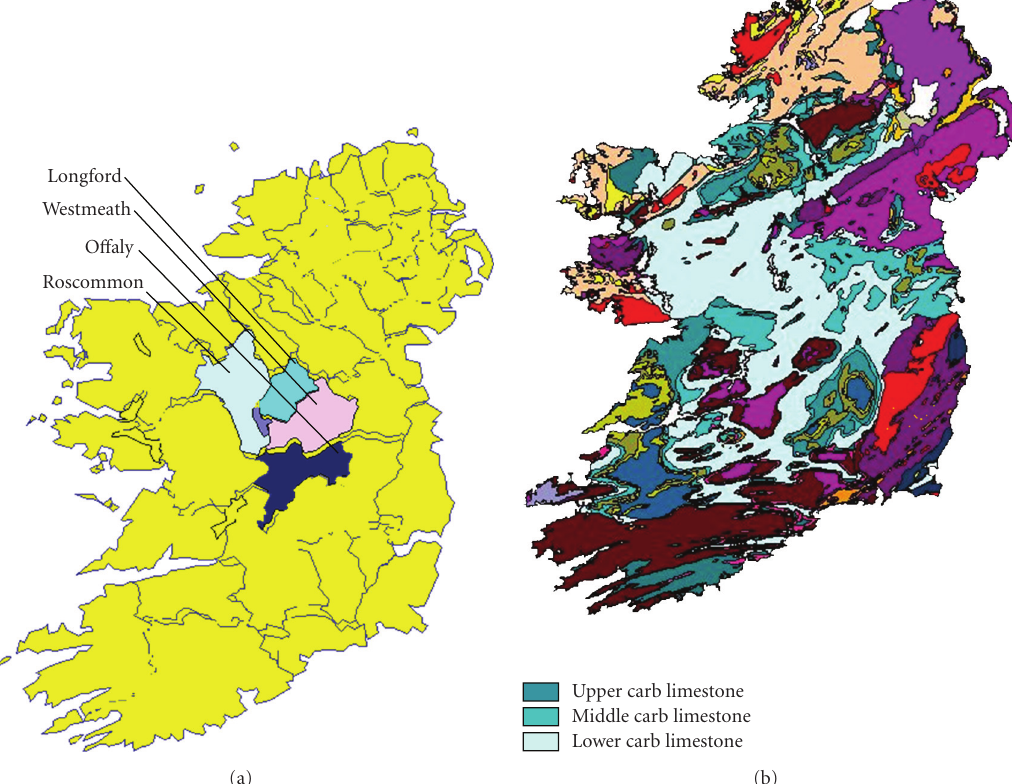
Figure 1: The test areas and the geological attributes of these areas (Ordnance Survey Ireland/Government of Ireland: Permit No.